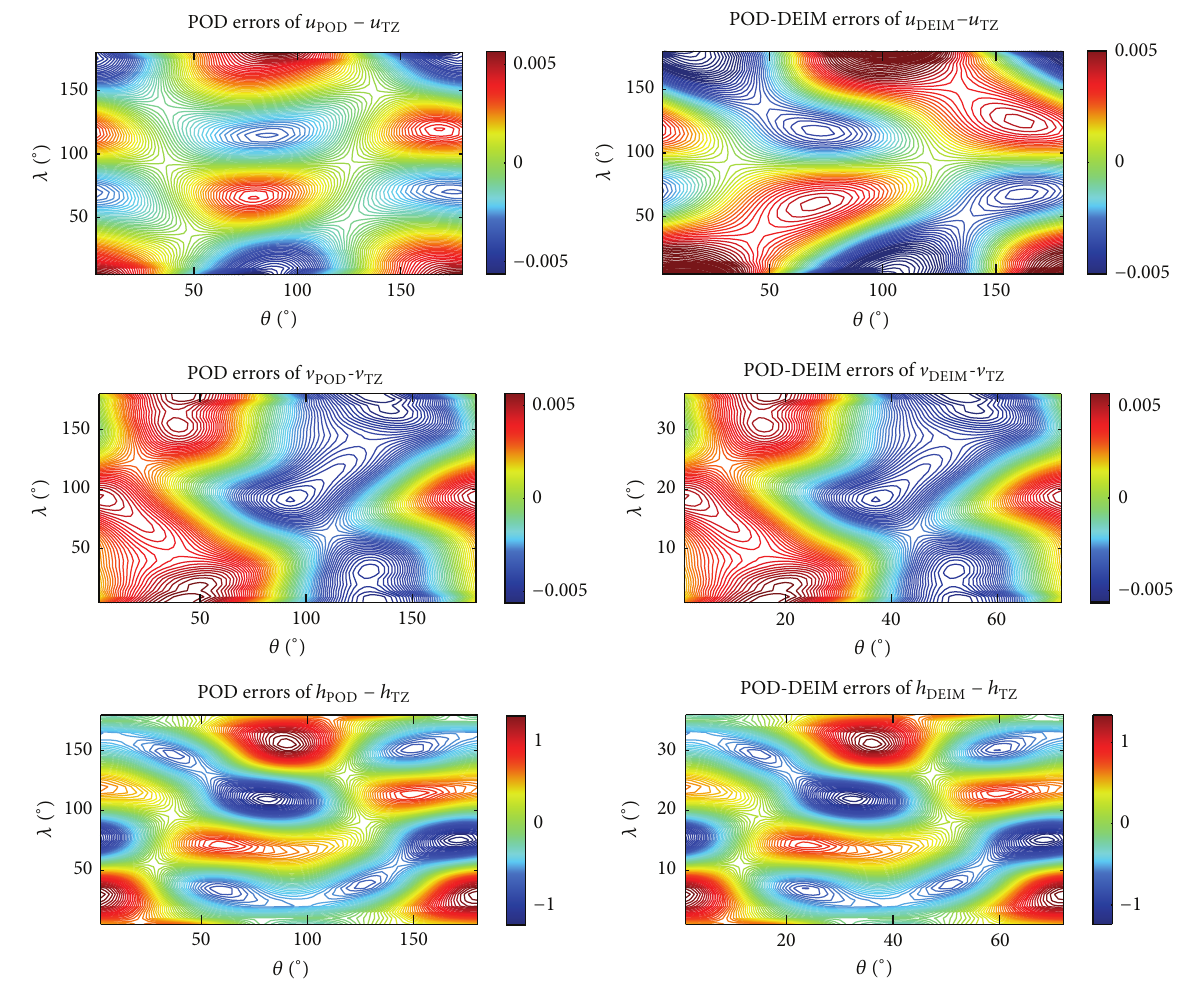
Figure 5: Local errors between POD, POD-DEIM solutions and the TZ FD solutions of spherical SWE at 𝑡 = 24 h ( Δ𝑡 = 800 s). The number of DEIM points was taken